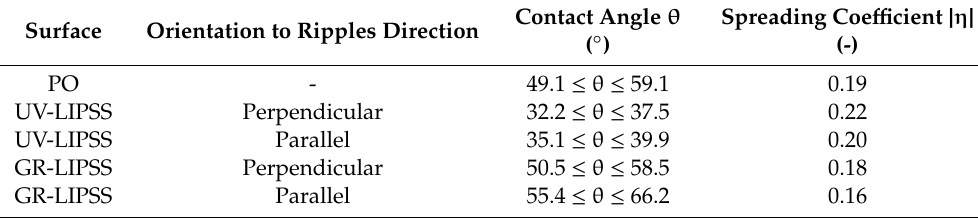
Table 5. Contact angle of water on PO and laser-textured surfaces.